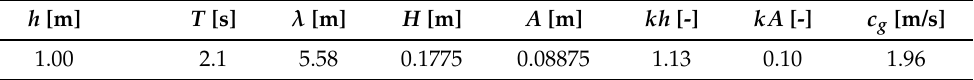
Table 1. Water depth, h , and wave parameters used in the present study (input and target parameters). h [m] T [s] λ [m] H [m] A [m] kh [-] kA [-] c g